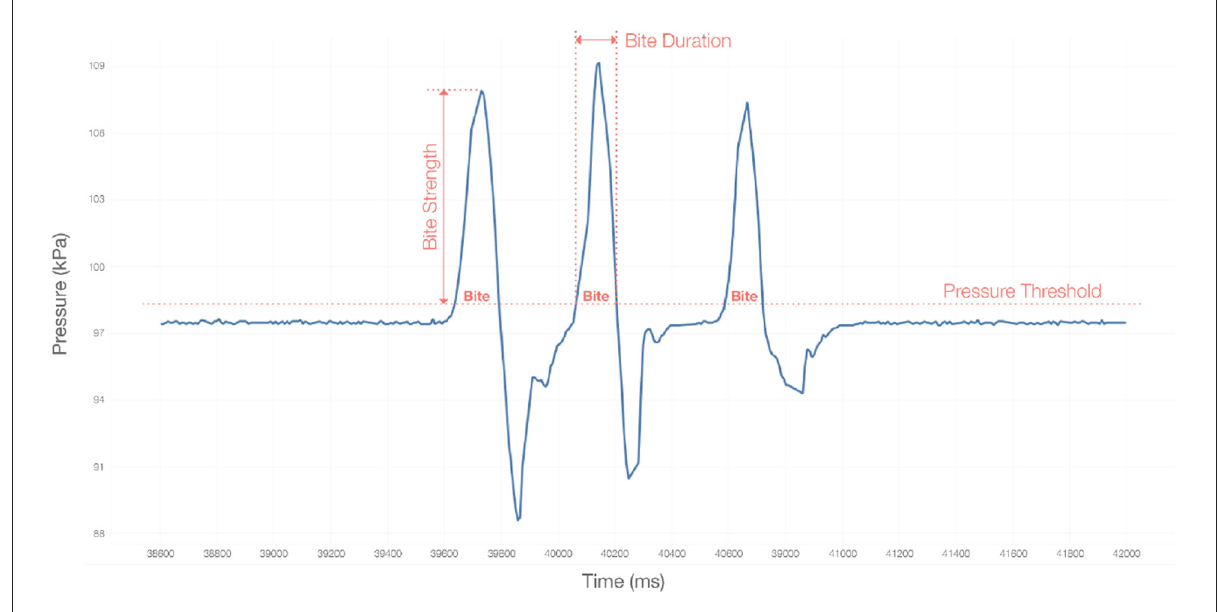
FIGURE4 A visual description of the engineered bite.